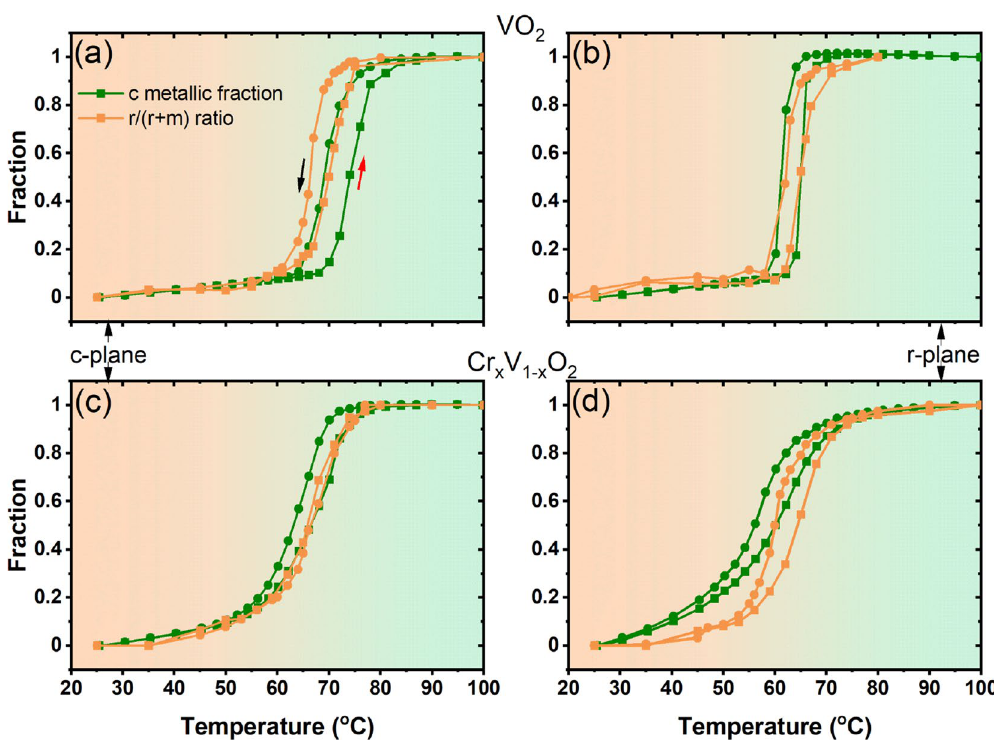
Figure 7. Metallic and rutile fraction analysis of undoped ( a , b ) and Cr-doped VO 2 ( c , d ) on c- and r-sapphire